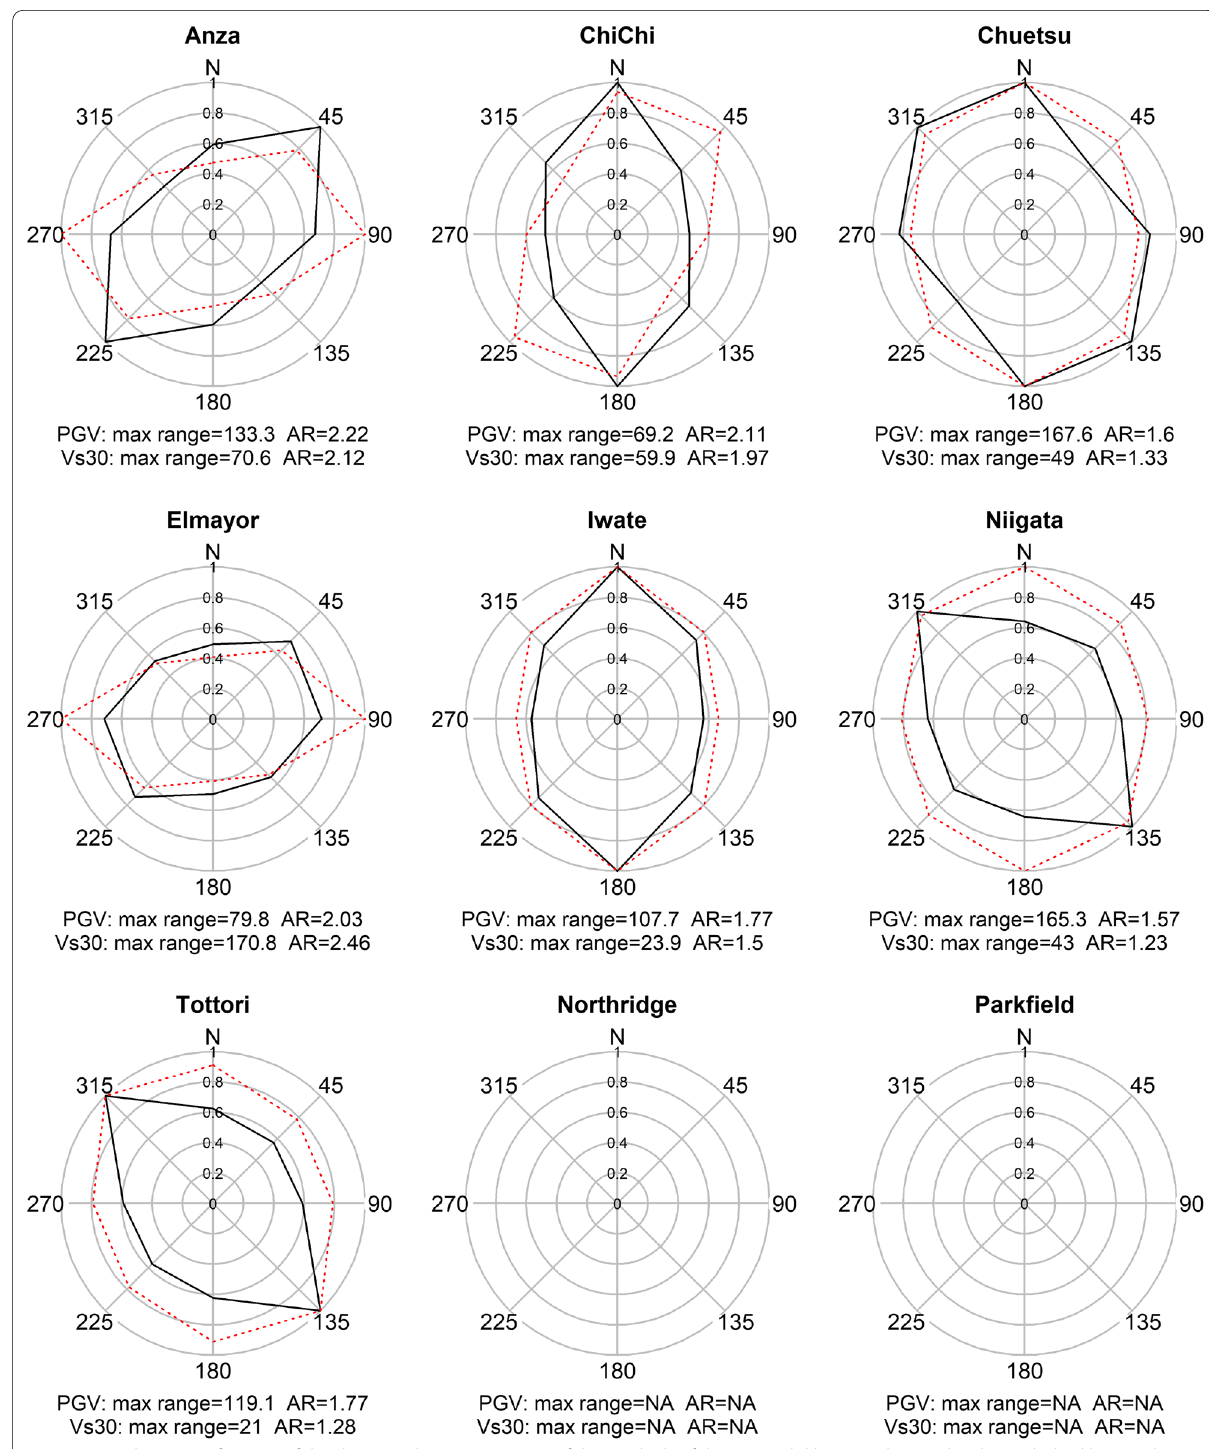
Fig. 5 Rose diagrams of ranges of the directional semivariograms of the residuals of the PGV (solid lines) and normalized V s30 (dashed lines) values at record stations of different